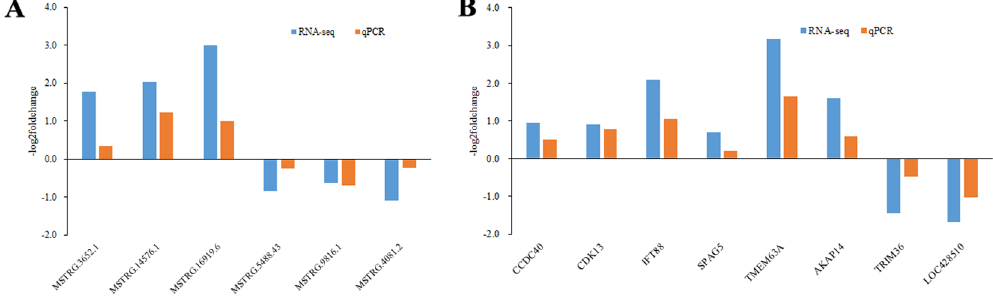
Figure 4. Illustrating of qPCR confirmation for RNA-seq. ( A ) Validation of 6 selected differential lncRNAs; ( B ) Validation of 8 selected differential mRNAs.